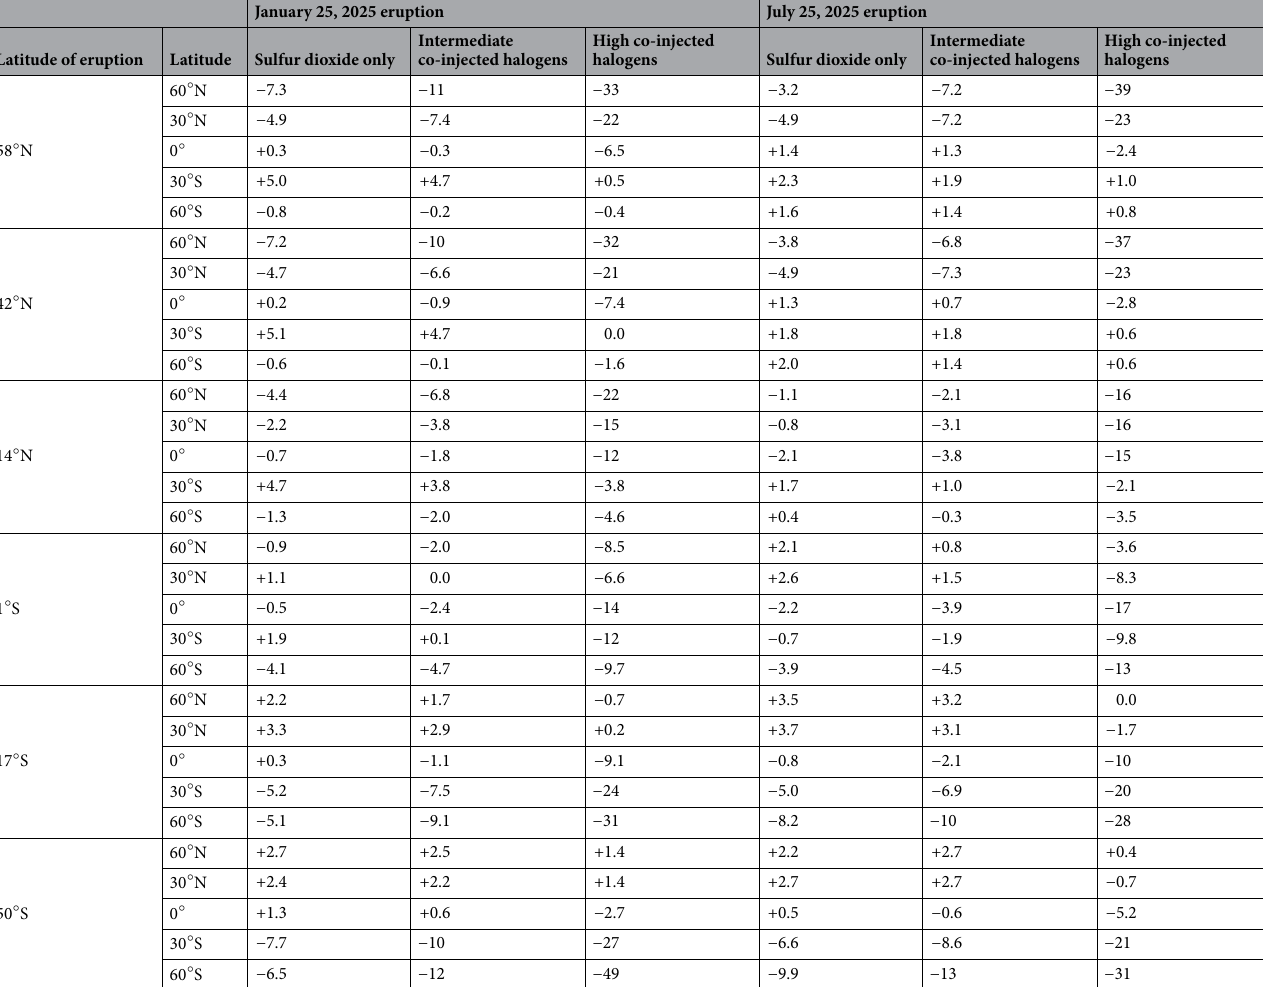
Table 1. Percent change in ozone across the globe, 5 months after the eruption. Ozone zonal mean column response in percent at specific latitudes 5 months after the eruption for all modelled scenarios. Latitudes shown highlight the impact on the tropical (0